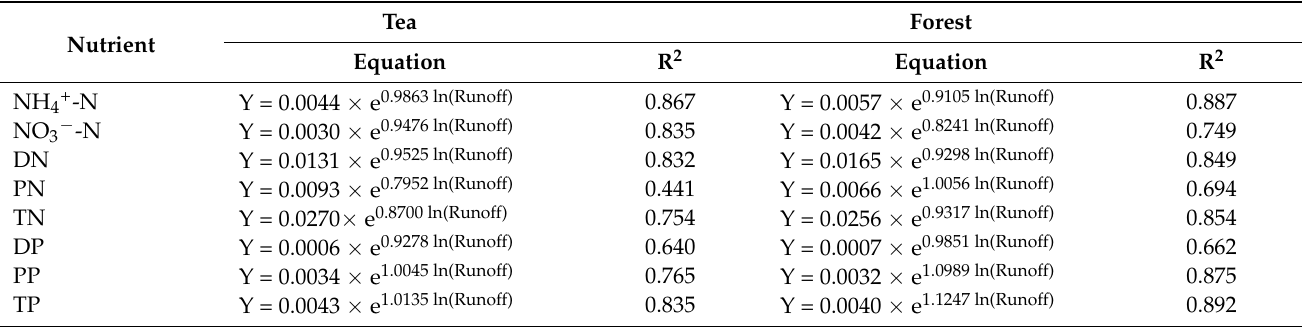
Table 4. Estimated fitting parameters and coefficients of determination (R 2 ) between the nitrogen and phosphorus losses and surface runoff after the hyperbolic logarithm transformation (ln(surface runoff)) in the tea and forest